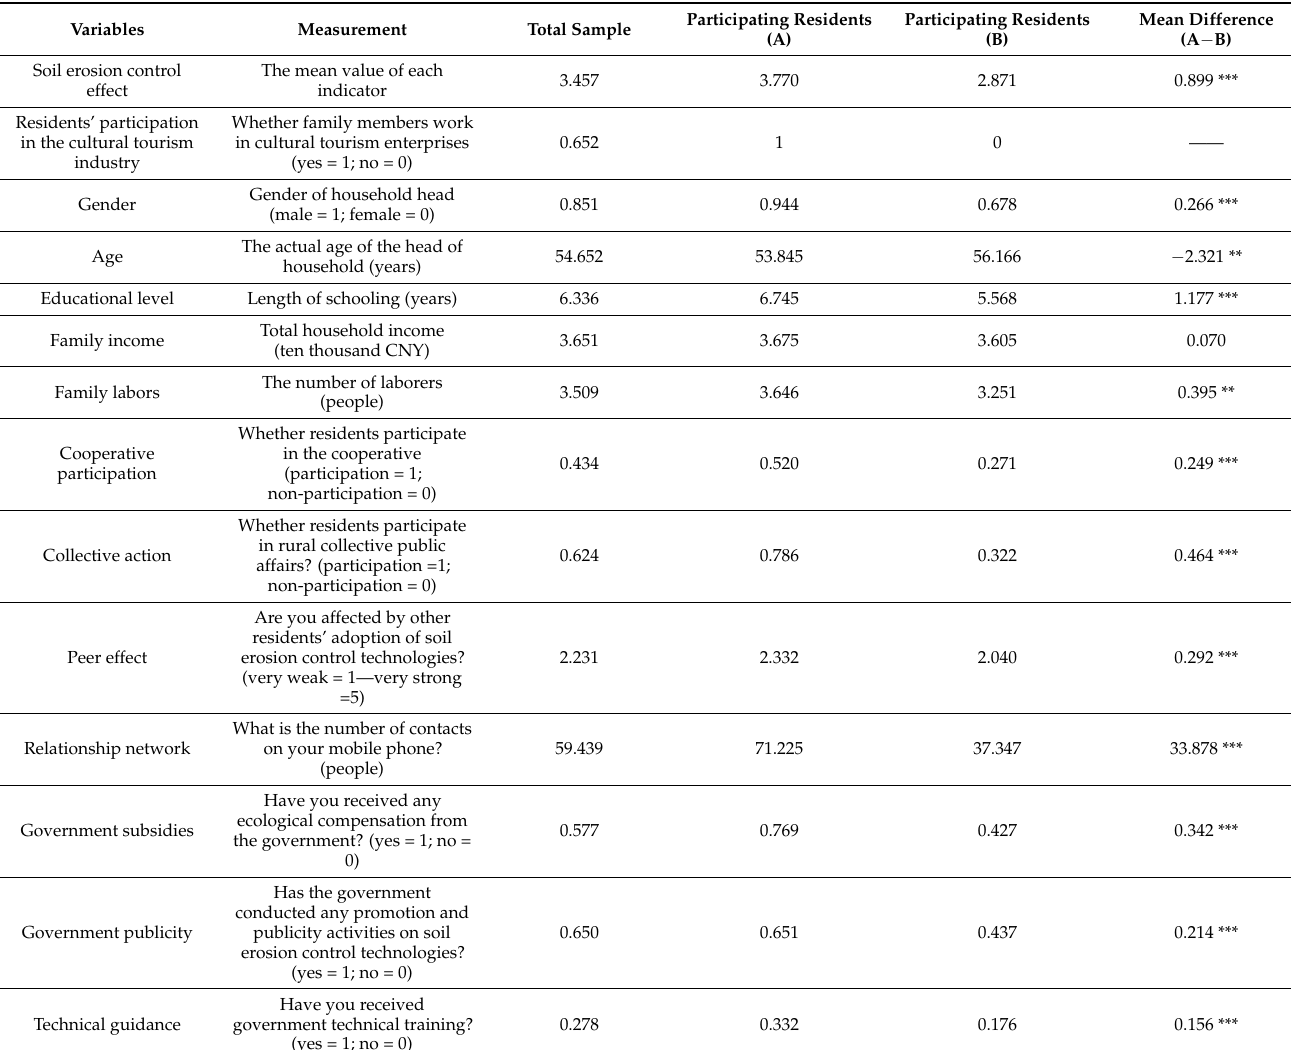
Table 1. Descriptive statistics of residents’ participation and non-participation in the cultural tourism